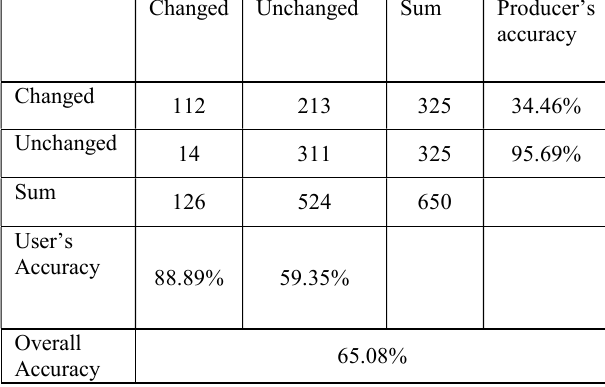
Table 8 Original change detection confusion matrix